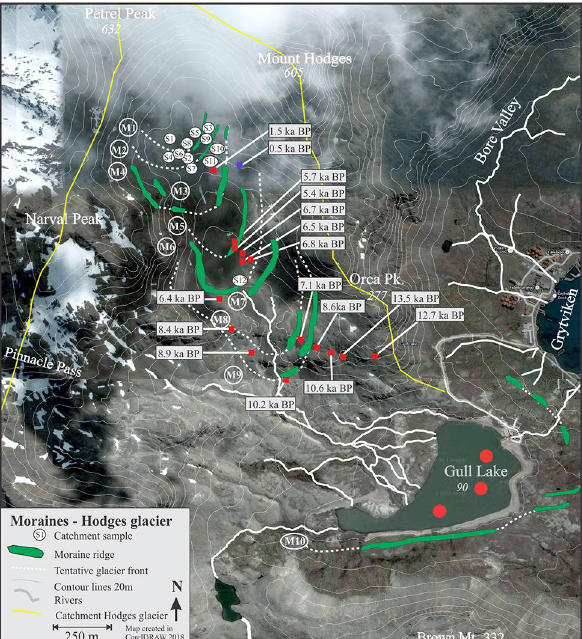
Figure 5. The moraines sequence in front of the Hodges glacier. Red circles indicate coring sites for the three long piston cores obtained in Gull Lake in 2008. Red squares indicate sampling locations on boulders and blue squares on bedrock surface for cosmogenic dating, and the subsequent ages are shown in white boxes (see Table S1 for details, including uncertainty